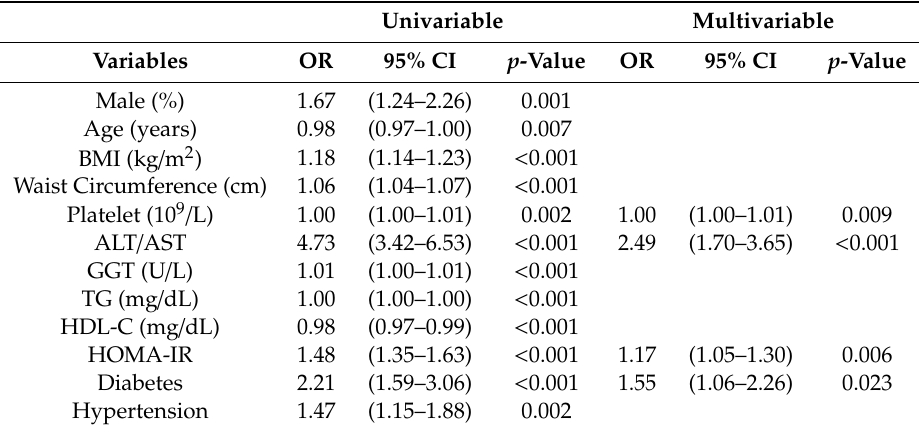
Table 3. Risk factors associated with hepatic